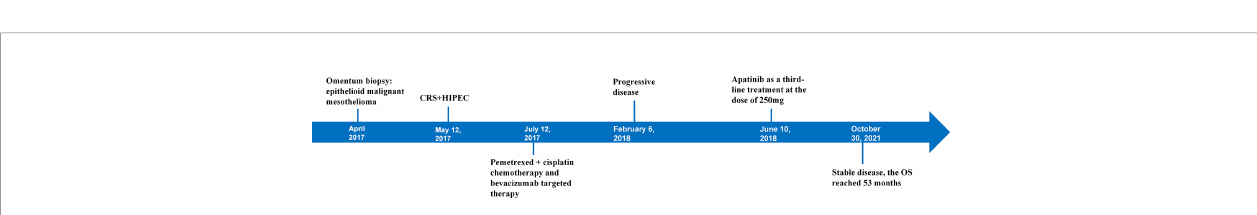
FIGURE 7 | Patient treatment fl owchart. CRS+HIPEC, Cytoreductive surgery plus hyperthermic intraperitoneal chemotherapy; OS, overall survival.